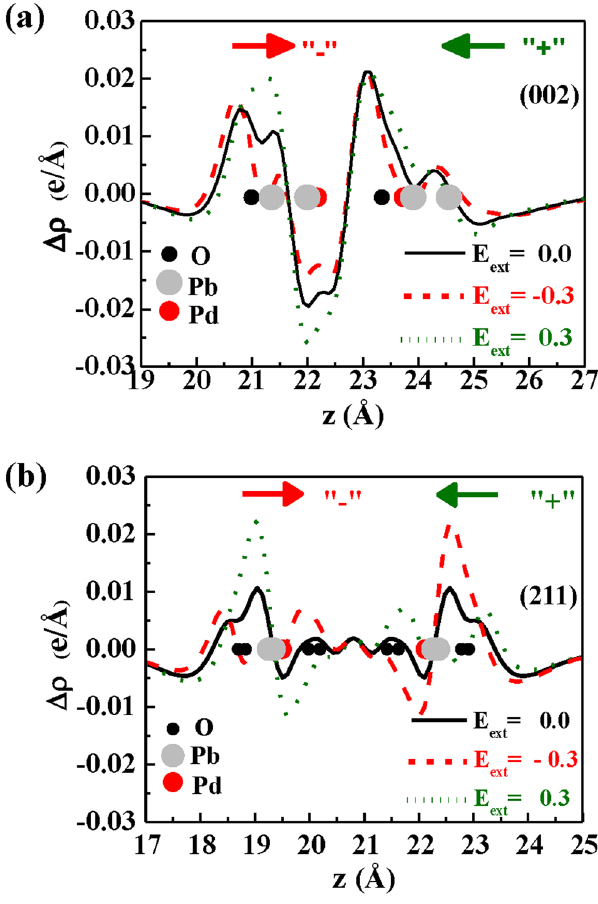
Figure 4. The plane-averaged electron density difference along the direction perpendicular to the slab with E ext = 0.0, ± 0.3 V/Å for ( a ) (002) and ( b ) (211) orientation slabs,